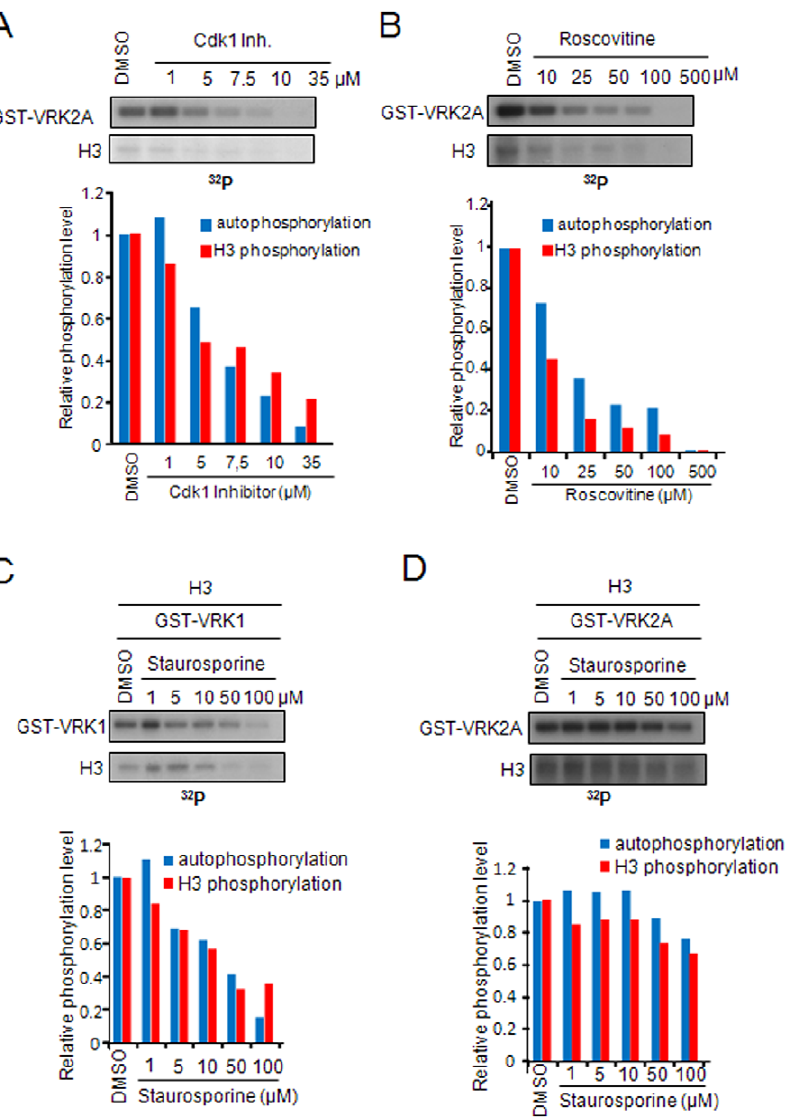
Figure 3. Differential effect of CDK inhibitors on VRK1 and VRK2 and discrimination between VRK1 and VRK2 by staurosporine. A . Inhibition of VRK2 by Cdk1 inhibitor. Quantification of the inhibition achieved on autophosphorylation and histone H3 phosphorylation is shown in the graph below. Quantification was performed in the linear response range. B . Inhibition of VRK2A by roscovitine, an inhibitor in phase II clinical trials. Quantification of the inhibition achieved on autophosphorylation and histone H3 phosphorylation is shown in the graph below. C . Inhibition of VRK1 activity by staurosporine. At the bottom the quantification in the linear response range is shown. D . Lack of effect of staurosporine on VRK2A activity. At the bottom the quantification in the linear response range is